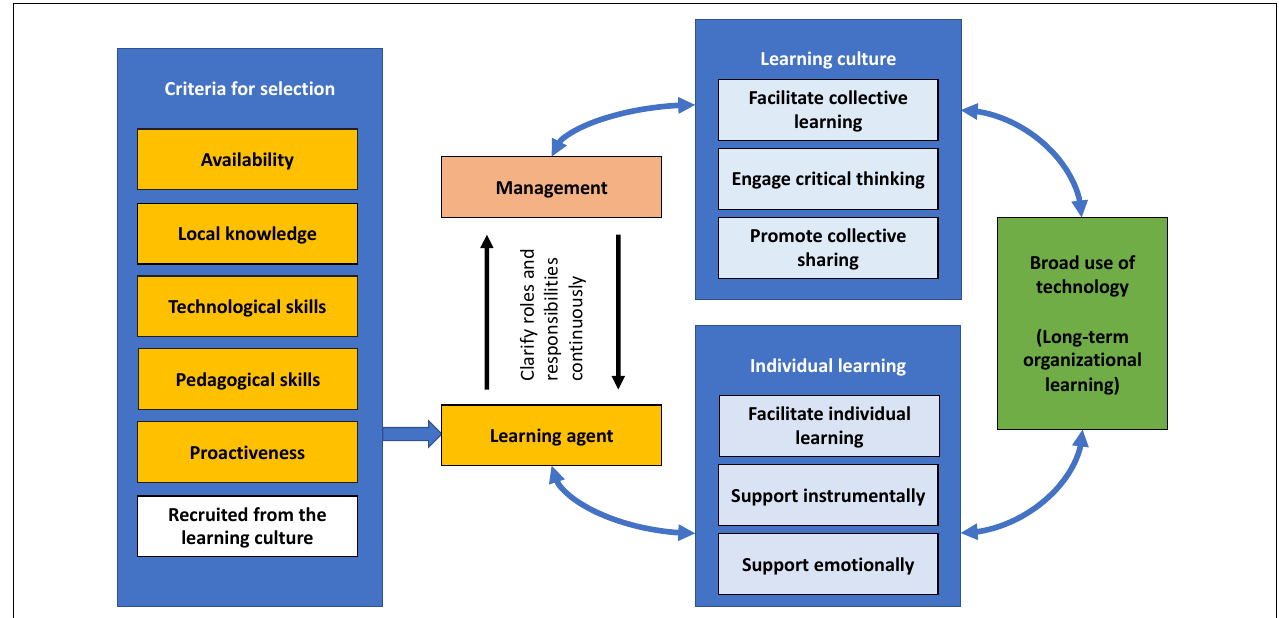
FIGURE 1 | The process of selecting a super user (learning agent) and the allocation of roles and responsibilities between the agent and management to ensure broad use of